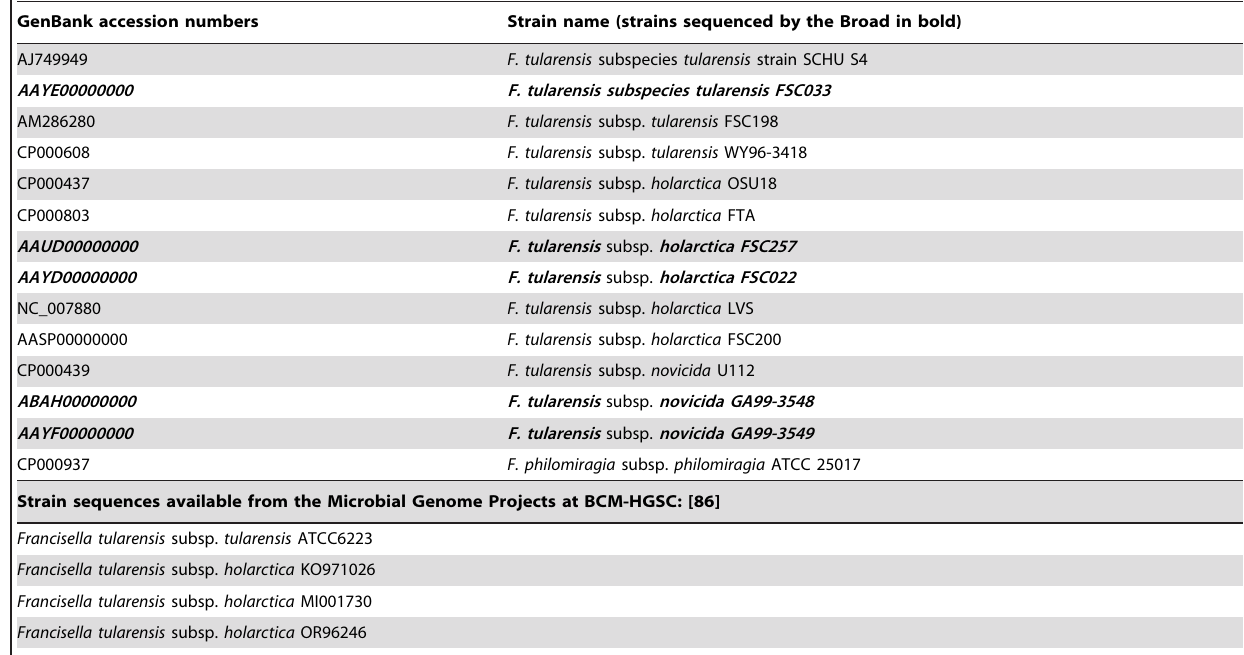
Table 7. GenBank Accession Numbers for Francisella Strains Used in This Study.